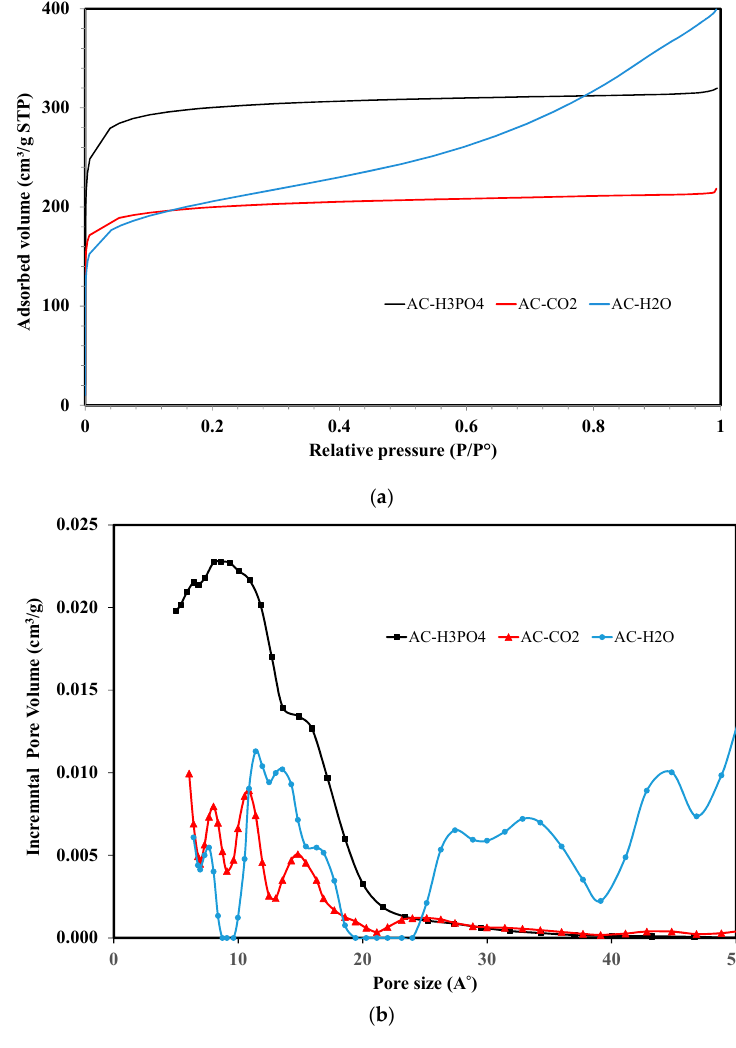
Figure 3. ( a ) Nitrogen adsorption/desorption isotherm of the different activated carbons; and ( b ) density functional theory (DFT) pore size distribution .